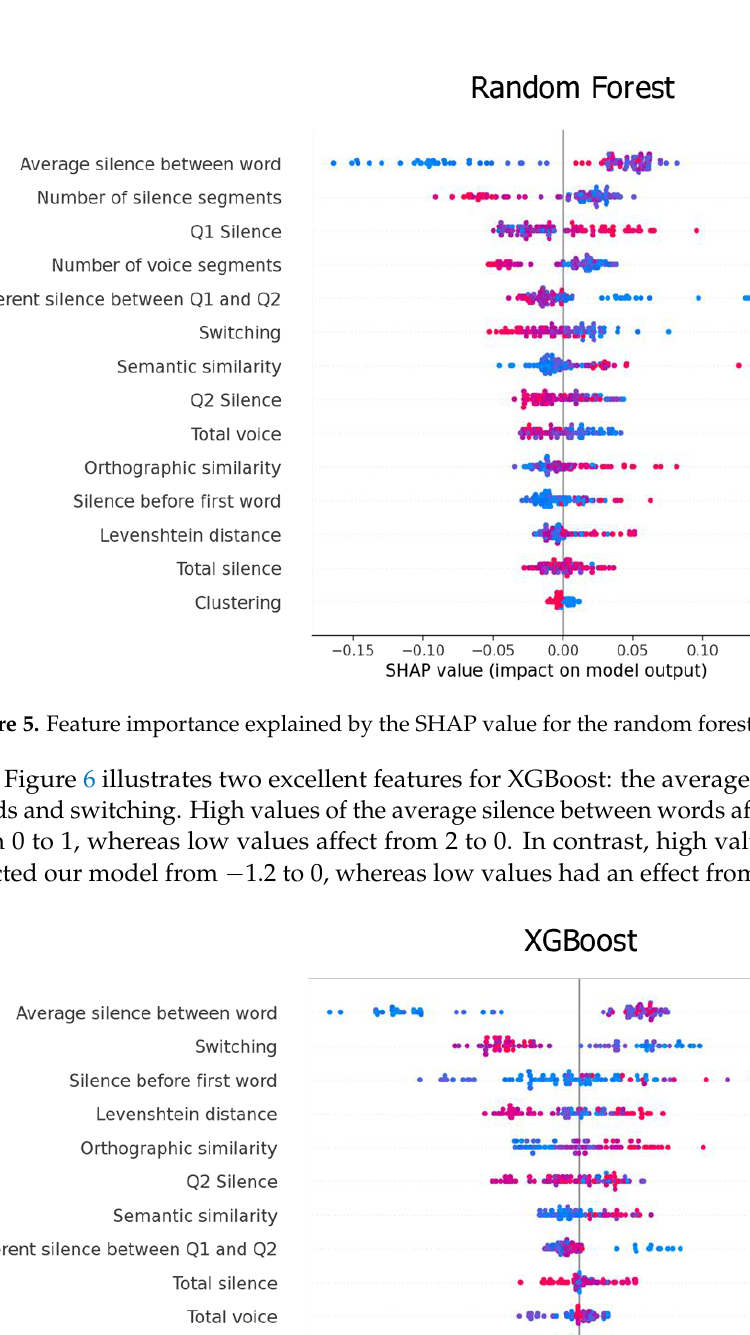
Figure 6 . Feature importance explained by the SHAP value for the XGBoost classifier.